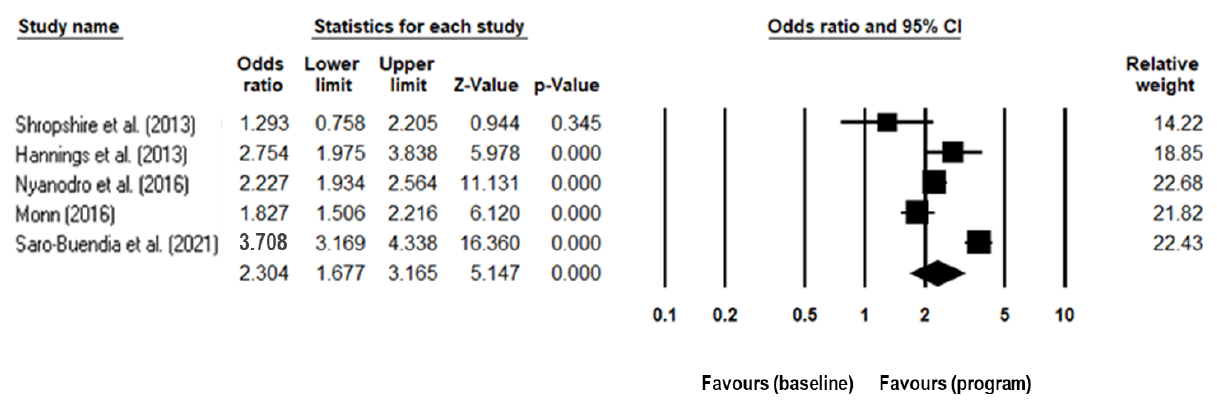
Figure 2. Seasonal flu vaccination rate (%) of included studies—intervention vs. baseline or control [16,42,43,45,47,48,50–52]. Remarks: Studies of Huang et al. [46], Roberto et al. [44], and Osborne et al. [49] are not shown on this chart as absolute vaccination rate was not provided in the literature.